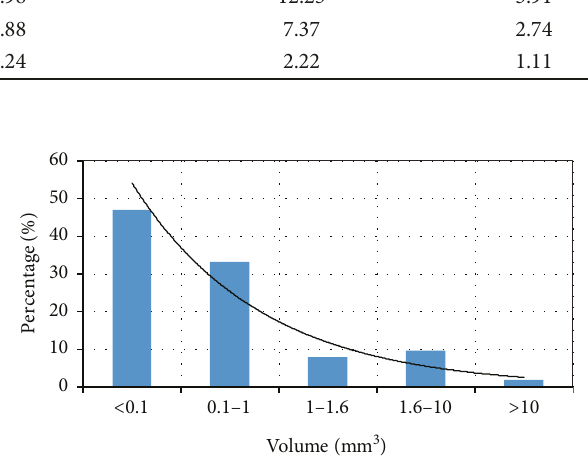
Figure 10: Volume distribution of